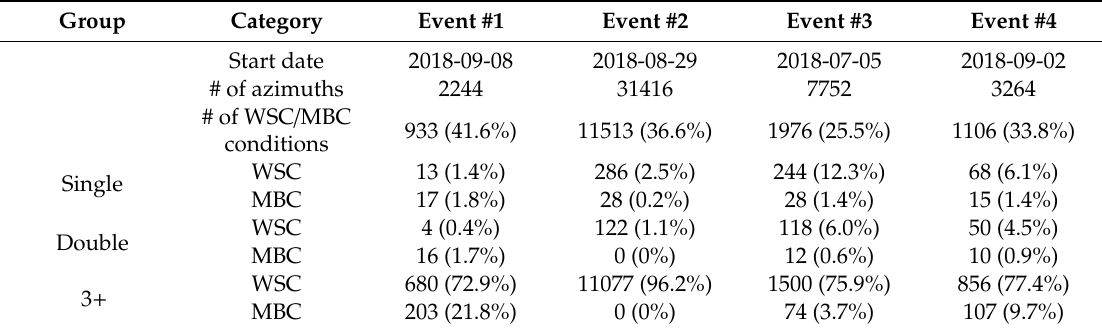
Table 3. Evaluation of the selected weather events (#1 − #4) from the perspective of all the scanned azimuths (i.e., all lidar beams): number of azimuths with fulfilled conditions for wind shear (WSC; 7.5 m / s ≤ ∆ v ≤ 15.0 m / s, i.e., empty pink circles) or for microburst (MBC; ∆ v ≥ 15.0 m / s, i.e., full pink circles), which are isolated (Single), form pairs next to each other (Double) or form groups with at least three members next to each other (3 + ).